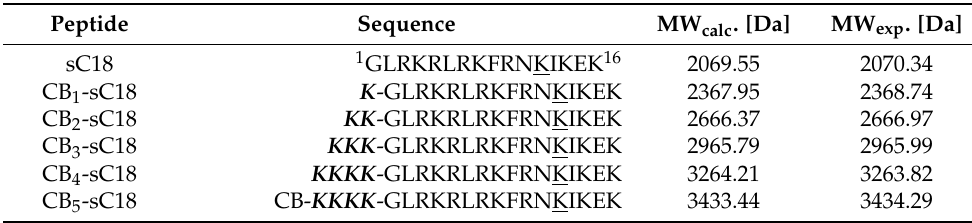
Table 1. Names, sequences, and analytical data of synthesized peptides. Peptides are C -terminally amidated. K : lysine with CB attached at the ε -amino group. K: labeling position for CF. Peptide Sequence Peptide